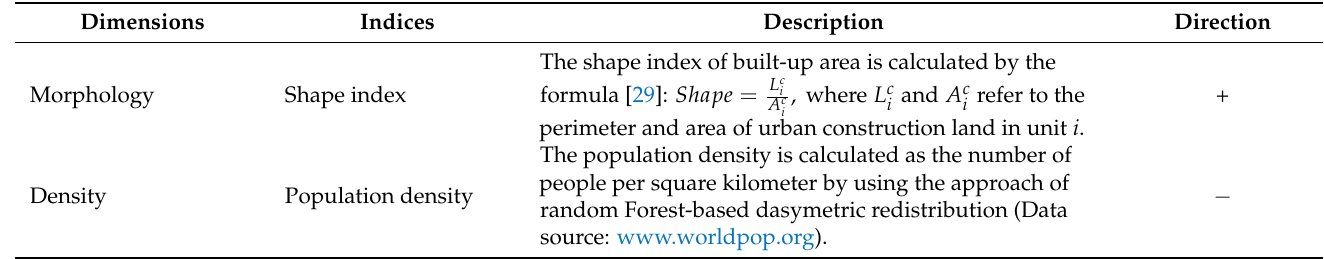
Table 2. The Multi-dimensional Indices of Urban